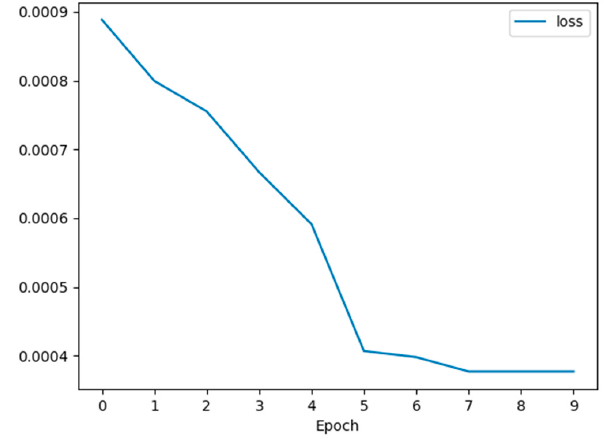
Figure 4. Adaptability values of the SSA for the IEEE14-bus test system.